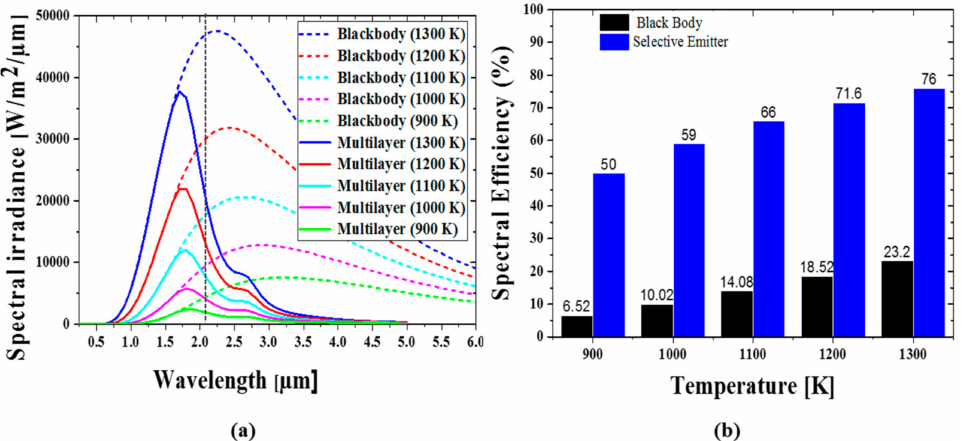
Figure 7. Comparison of the spectral irradiance and the spectral efficiency of a black body with the designed selective emitter at 900 K, 1000 K, 1100 K, 1200 K, and 1300 K. ( a ) Spectral irradiance of the